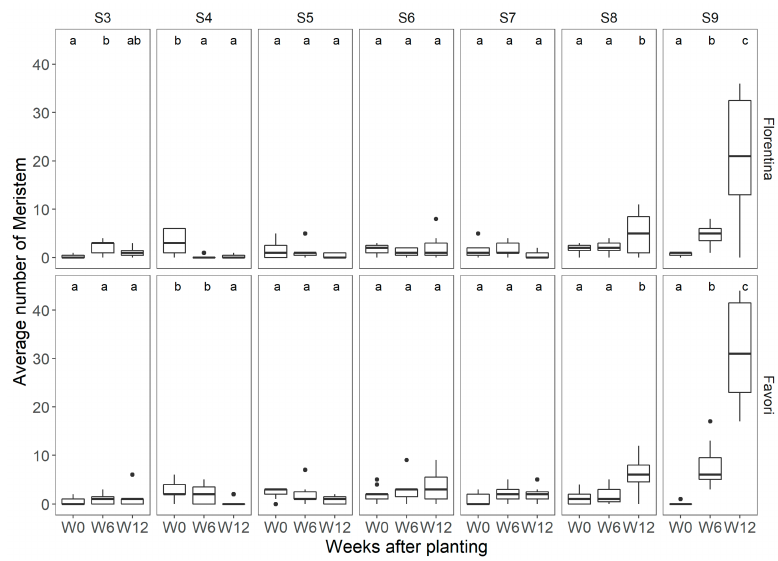
Figure 9. Boxplots of the meristem development stages (S3–S9) at three timepoints (W0, W6, and W12) for plants of the strawberry cultivar ‘Florentina’ and ‘Favori’ grown in a greenhouse at ambient long photoperiod at 20 ◦ C for 14 weeks, where N = 7. Pairwise comparison between the week, where the different letters above the boxplots represent statistical differences, while similar letters indicate no significant difference between cultivars by the Tukey test at 5% of error probability ( p < 0.05).